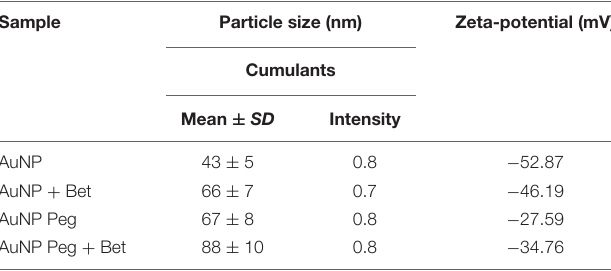
TABLE 2 | Particle size and zeta-potential values of the nanogold samples.